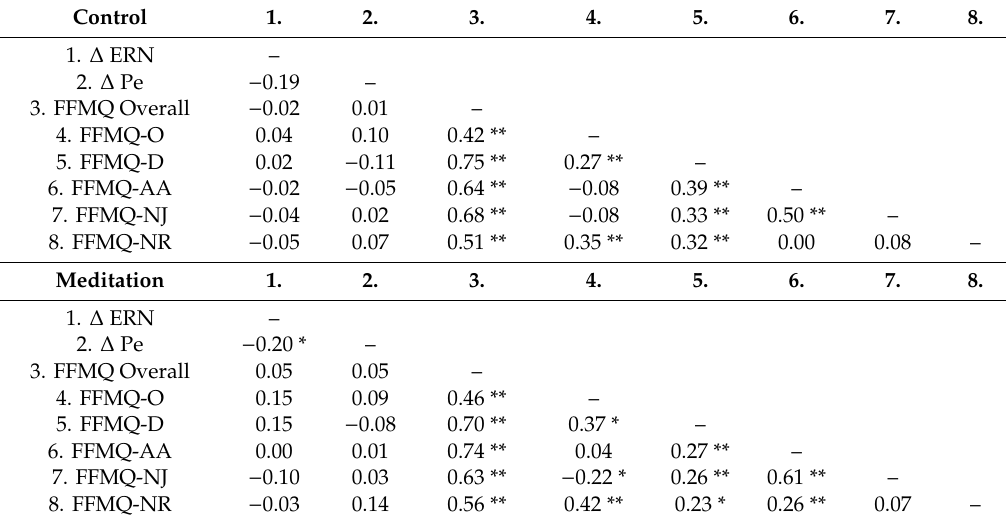
Table 4. Bivariate correlations among trait mindful awareness and ERP measures by group.